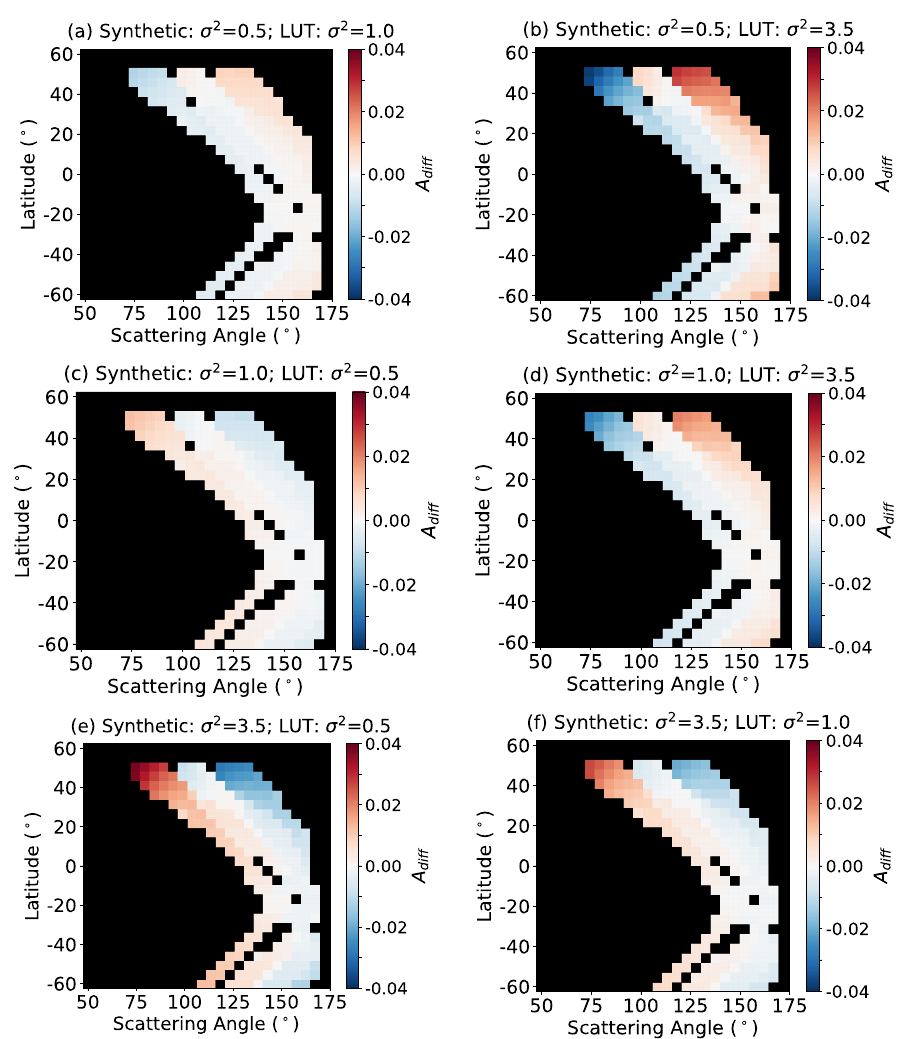
Figure 5. The variations of median A diff values with latitude and scattering angle computed from a synthetic dataset generated with the R05 model ( a , b ), the R10 model ( c , d ), and the R35 model ( e , f ), and then retrieved using the LUTs with the other two models.